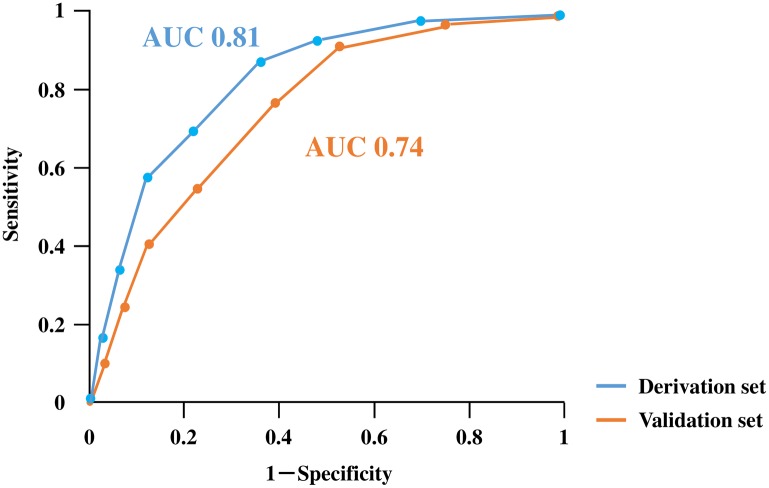
ROC curve of the derivation and validation set in the laboratory model.AUC, area under the curve.